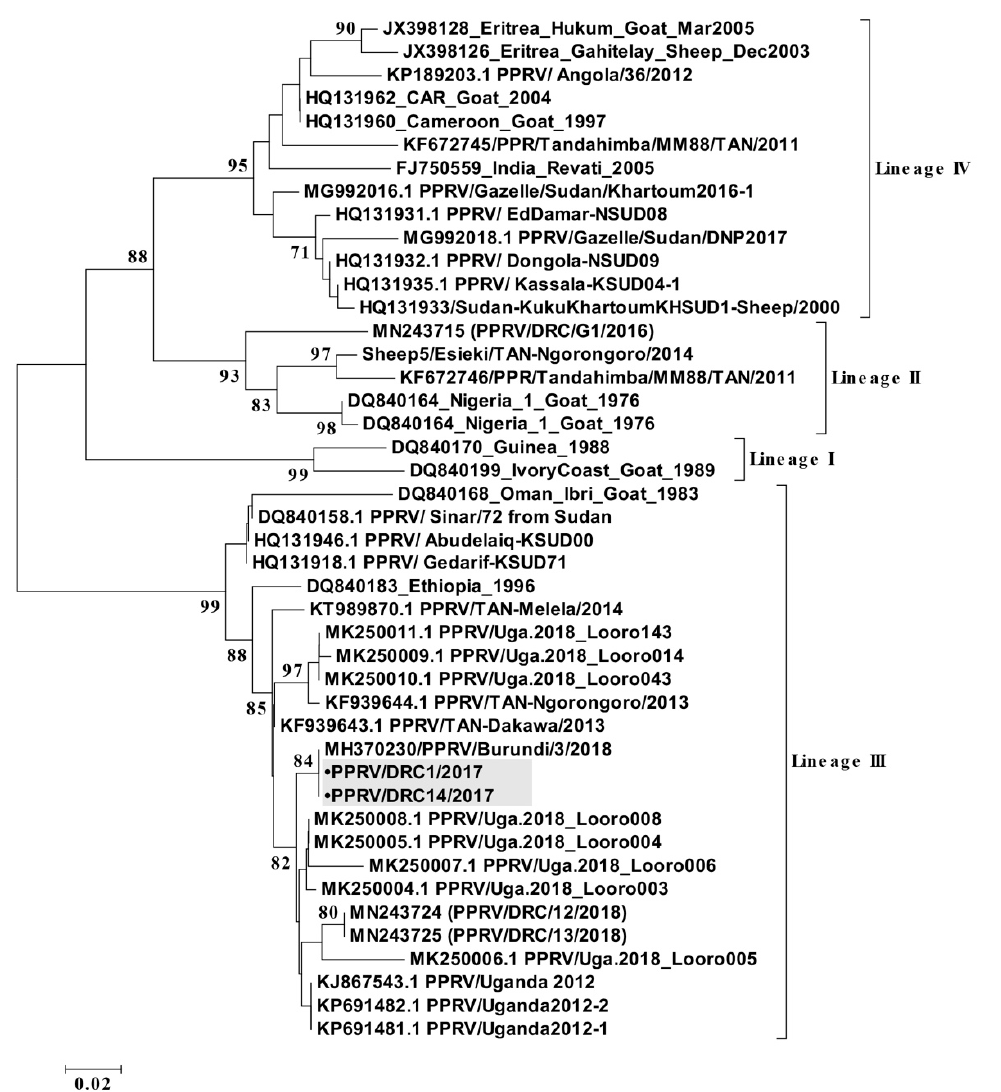
Figure 5. A neighbor-joining tree constructed using partial N-gene (255 nucleotides) sequences of peste des petits ruminants virus (PPRV), shows the relationships among the PPRV isolates. The Kimura 2-parameter model was used to calculate the percentage (indicated by numbers beside branches) of replicate trees in which the associated taxa clustered together in 1000 bootstrap replicates. The sequences from DRC generated in this study PPRV / DRC / 01 / 2017 (MT154039) and PPRV / DRC / 14 / 2017 (MT154040) are indicated with a shaded grey box, were identical to the Burundi sequence (MH370230) and related to other isolates from north-eastern Uganda and eastern DRC 2018 (MN2434724-25). The scale bar indicates nucleotide substitutions per site.